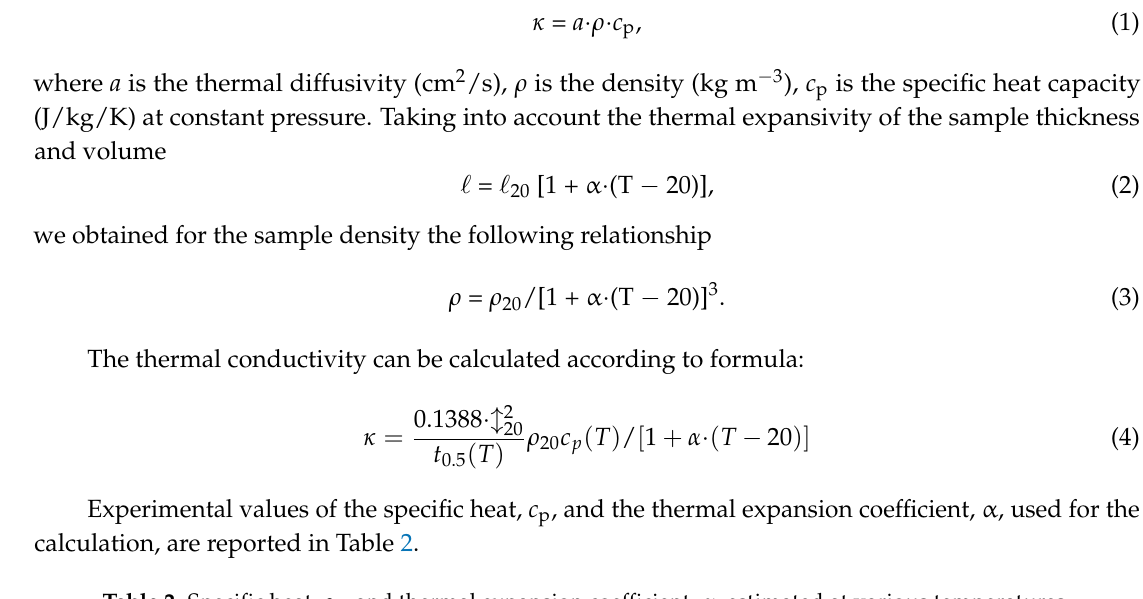
Table 2. Specific heat, c p , and thermal expansion coefficient, α , estimated at various